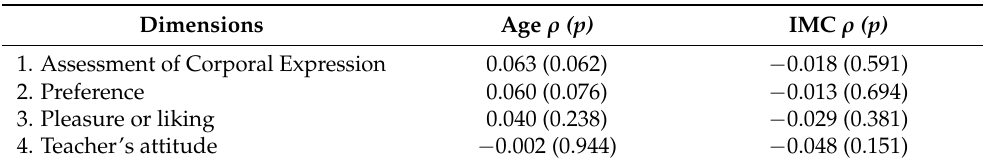
Table 4. Correlations between the dimensions and the age group